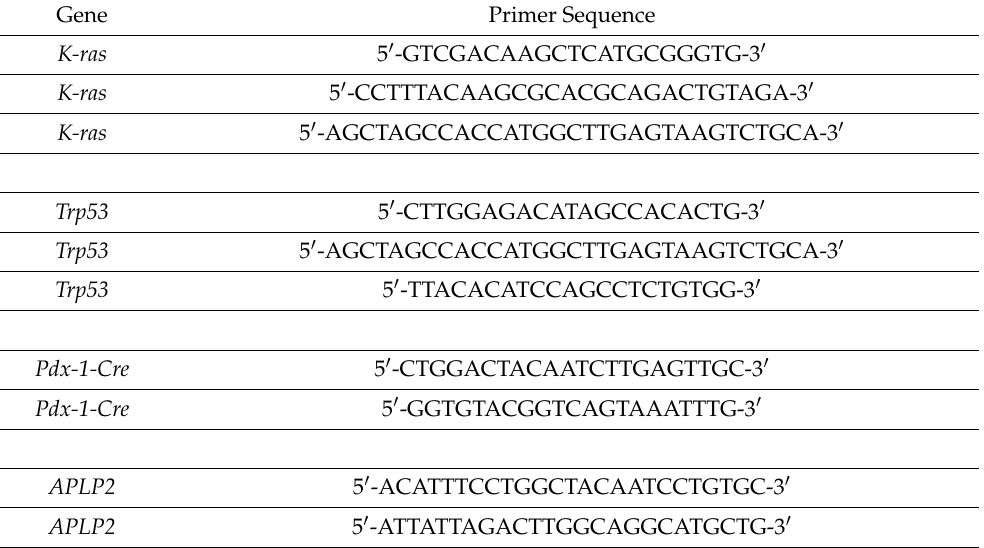
Table 2. PCR primer sequences for